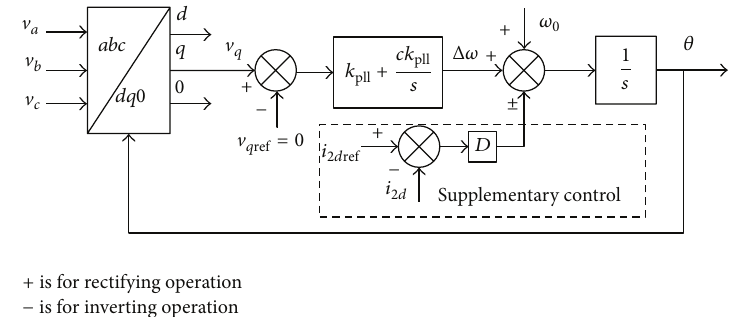
Figure 6: Improved PLL control for VSC connected to weak AC system.